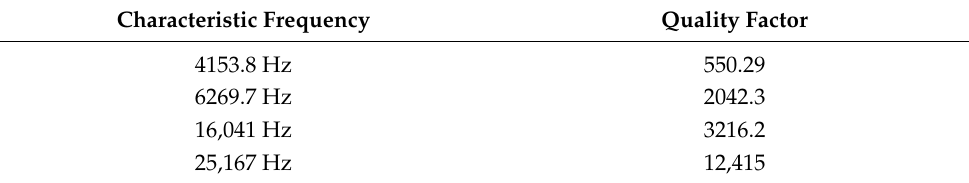
Figure 3. Working modal simulation of the cantilever resonator (Characteristic frequency ( a – d ): 4153.8 Hz, 6269.7 Hz, 16,041 Hz, 25,167 Hz). Table 1. Simulated characteristic frequencies and quality factors of cantilever